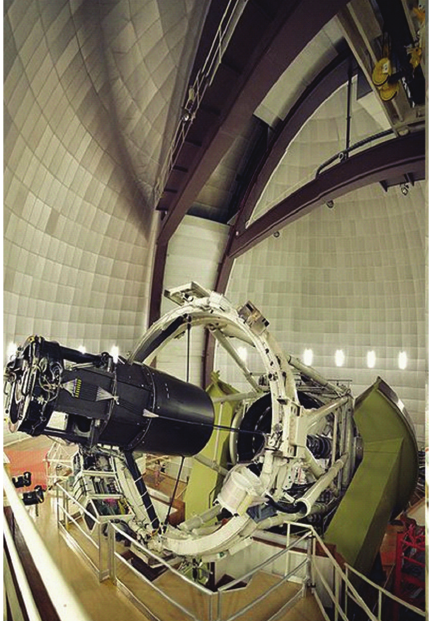
Figure 3: The 3.9m Anglo-Australian Telescope is one of the first ones which made use of Tpoint , adapted from [15].